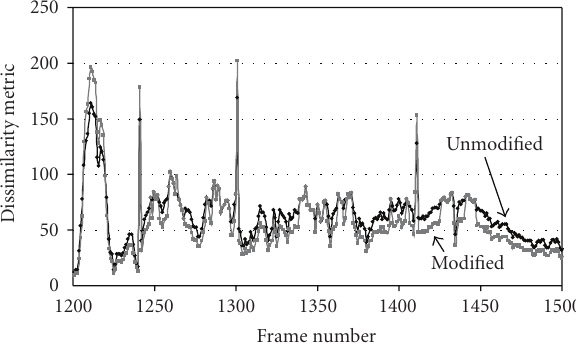
Figure 5: Performance of unmodified and modified dissimilarity metric exploiting local scale information provided by virtual frame partition.